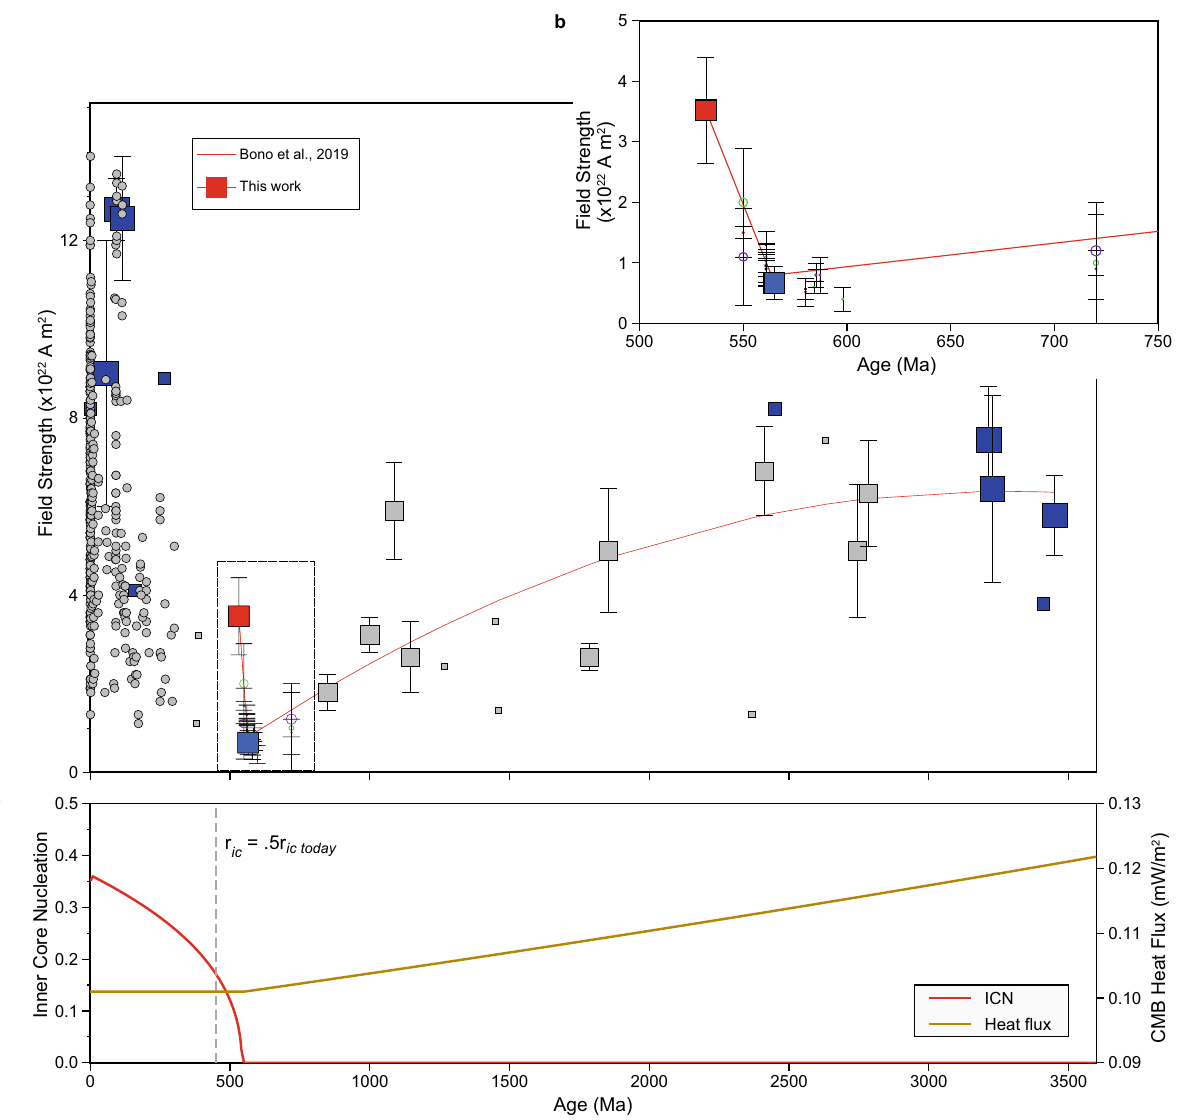
Fig. 3 Early Cambrian fi eld renewal and inner core growth. a Field strength constrained from select Thellier (thermal) single-crystal paleointensity (SCP) studies (blue squares) and bulk rock studies (gray squares) updated from ref. 7 , with new early Cambrian SCP result (red square) reported here. Large squares are time-averaged paleomagnetic dipole moments; small squares are virtual dipole moments (VDMs). Gray circles are select Phanerozoic VDMs from ref. 7 . Field evolution model (3450 Ma to 565 Ma, red line) is weighted second-order polynomial regression of Precambrian fi eld strength data from ref. 7 ; 565 to 532 Ma trend connects the Ediacaran paleomagnetic dipole moment of ref. 7 , and the new Early Cambrian paleomagnetic dipole moment from this work. Error bars are 1 σ . b Ediacaran to Cambrian fi eld strength evolution corresponding to a dashed rectangle in a . Open circles are results from non-Thellier methods (non- thermal and thermal) and their sizes are weighted by the number of cooling units. Key: green, microwave method; purple, Shaw method; black, Wilson method. Brown open circles are Thellier thermal results. c Thermal model 49 showing inner core nucleation (ICN) age versus core-mantle boundary (CMB) heat fl ux. Dashed vertical line is the time when the inner core (radius = r ic ) is 50% of its current size ( r icmodern ), the location of the change observed in seismic anisotropy 1